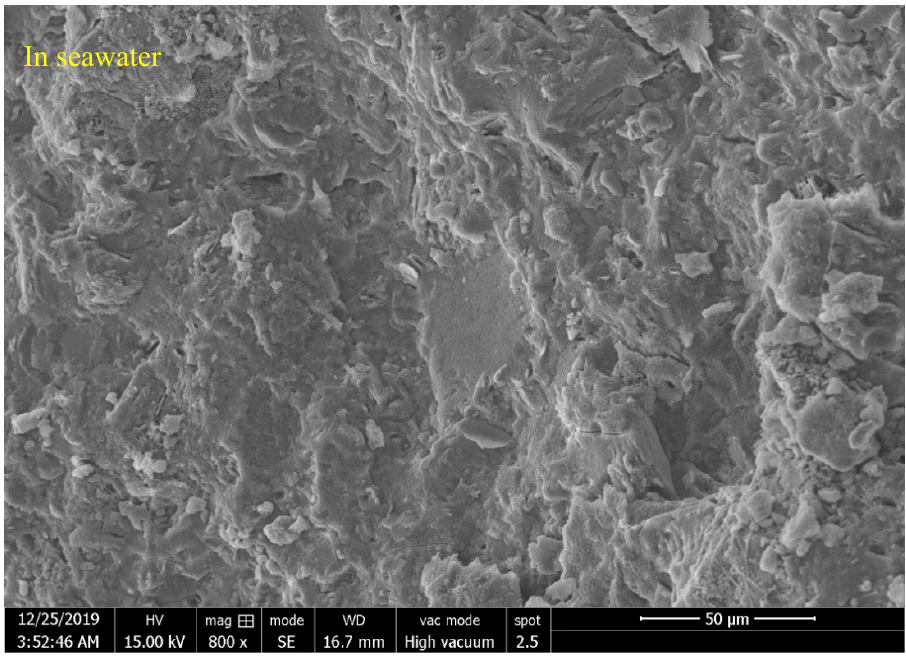
Figure 7. SEM images of the geopolymers prepared with 60% metakaolin.